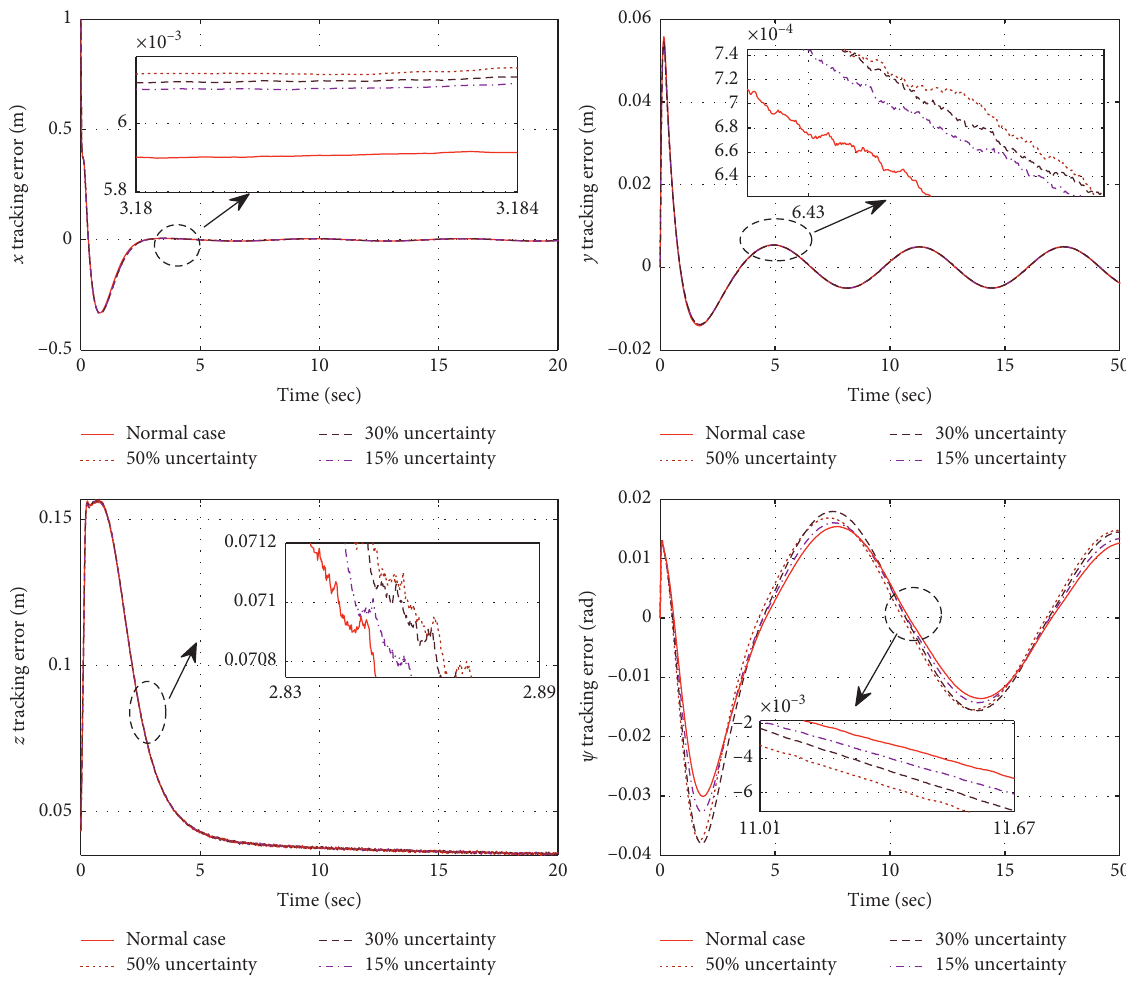
Figure 17: The tracking errors of different uncertainty cases added in the z rotating axis. Table 4: The MVTE and